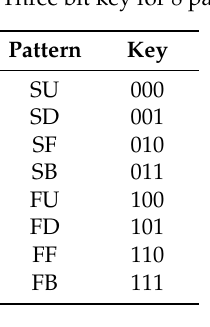
Table 1. Three bit key for 8